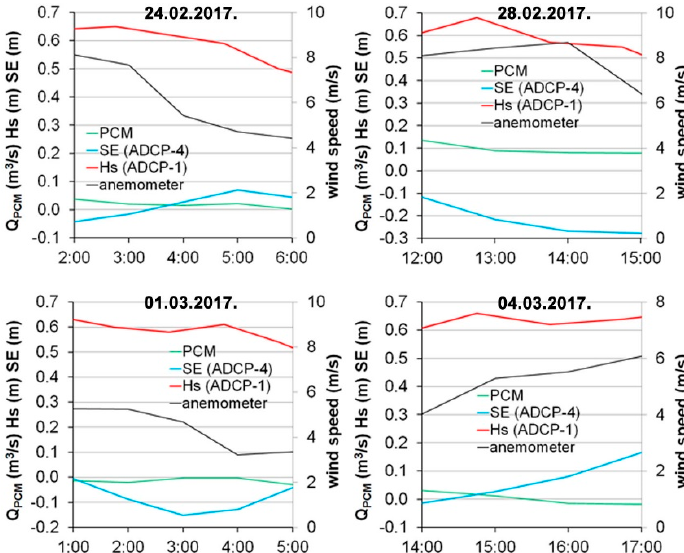
Figure 21. Hourly averaged field measured values of significant wave height ( H S ), surface elevation (SE), flushing culvert discharge measured with the PCM and wind velocity, during situations where the wave parameters were approximately equivalent.